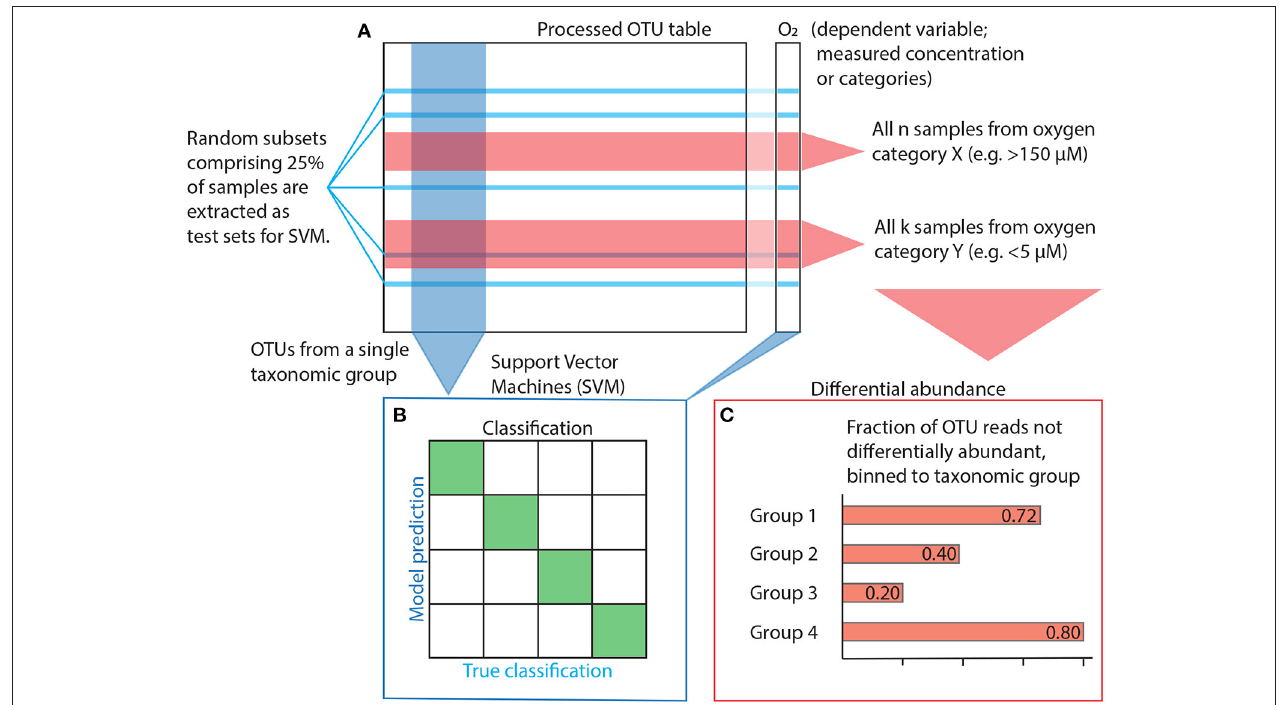
FIGURE 2 | Statistical workflow. (A) The OTU table is subset and prepared depending on the method used. Subsetting for SVM is shown in blue, subsetting for differential abundance in red. (B) Model input for SVM is constructed using OTUs from within a single taxonomic group plus oxygen as the dependent factor variable for estimation of accuracy, i.e., the ability to classify a sample correctly. (C) Differential abundance is quantified as the variance of the log ratio (VLR) between all OTU pairs and across all oxygen category pairs (e.g., cats. 1 vs. 7, cf. Table 1 ). For a given pair of OTUs, if their VLR is low within categories but high between, then at least one of them is differentially abundant with regards to the other along the oxygen gradient spanned by the two categories. However, instead of looking at the differential abundance of OTUs, we focus on OTUs that are never differentially abundant, indicating that their variance does not change sufficiently in relation to any other OTU across the category pairs of interest. A high fraction non-differentially abundant reads suggests a weak response to changes in oxygen